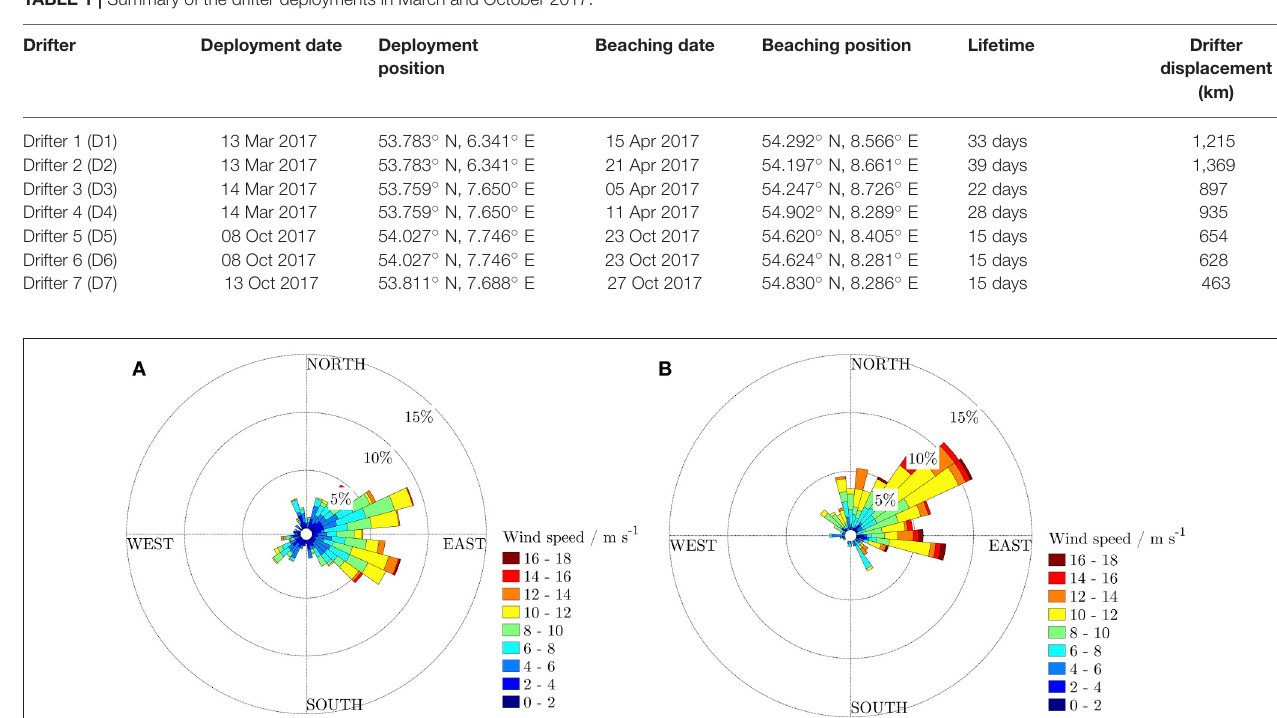
Beaching date Beaching position Lifetime Drifter position